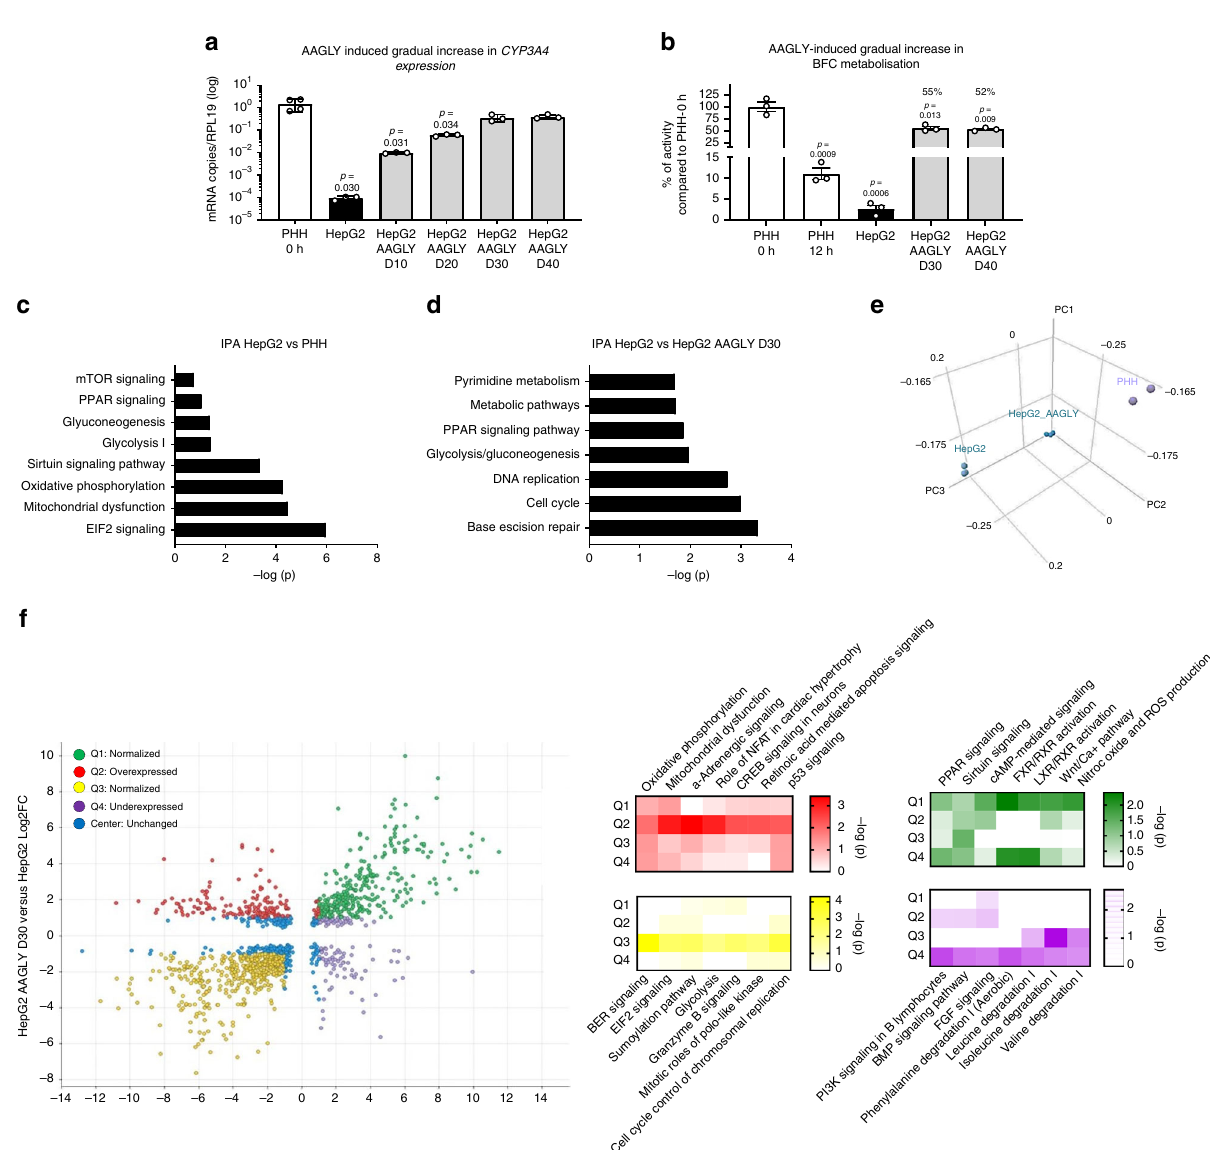
Fig. 5 High amino acid concentrations allow for further maturation over time of CYP450 enzymes in HepG2. a Gene expression analysis for CYP3A4 in HepG2 grown for an extended time in AAGLY-supplemented medium and compared with freshly thawed PHHs. N = 3 independent maturations of HepG2 cells. N = 4 donors for PHHs. Data on PHHs was repeated from Fig. 4. Signi fi cance was calculated by comparing with PHH 0 h by unpaired two-tailed Student ’ s t -test. b Relative BFC metabolization by HepG2 grown in AAGLY-supplemented medium for 30 or 40 days and compared with PHH 0 h and PHH 12 h. N = 3 independent maturations of HepG2 cells. N = 4 donors for PHHs. Data on PHHs was repeated from Fig. 4. Signi fi cance was calculated by comparing with PHH 0 h by unpaired two-tailed Student ’ s t -test. c IPA comparing HepG2 with PHHs. d IPA comparing HepG2 with HepG2 AAGLY D30. e PCA plot showing three samples of HepG2 grown in either standard medium (HepG2) or AAGLY-supplemented medium (HepG2 AAGLY) and three donors of PHH 0 h. f Quadrant analysis showing pathways that are normalized (Q1 and Q3), overexpressed (Q2), or underexpressed (Q4) when comparing HepG2 with PHH 0 h and HepG2 AAGLY D30. Color intensity correlates with − log( p ). Data in all panels represent mean ± SEM with P -values indicated when signi fi cant. Source data are provided as a Source Data fi upstream regulators of AMPK and eIF2alpha, LKB1 and GCN2 , did not affect CYP3A4 levels both in control media or AAGLY media (Supplementary Fig. 6B, C). In both HepG2 (Fig. 6a), HLC and HC3X (Fig. 6b), mTORC1 appeared to regulate CYP3A4 expression rather than translation. Finally, although KO of the mTORC1 inhibitor Tuberous sclerosis ( TSC)1 was not suf fi cient for driving maturation in HepG2, culture of TSC1 KO HepG2 in AAGLY medium yielded an even greater induction of CYP3A4 compared with wild-type HepG2 (Fig. 6a, c). This data suggests a crucial, but not suf fi cient role, for the activation of mTORC1 in inducing CYP3A4.